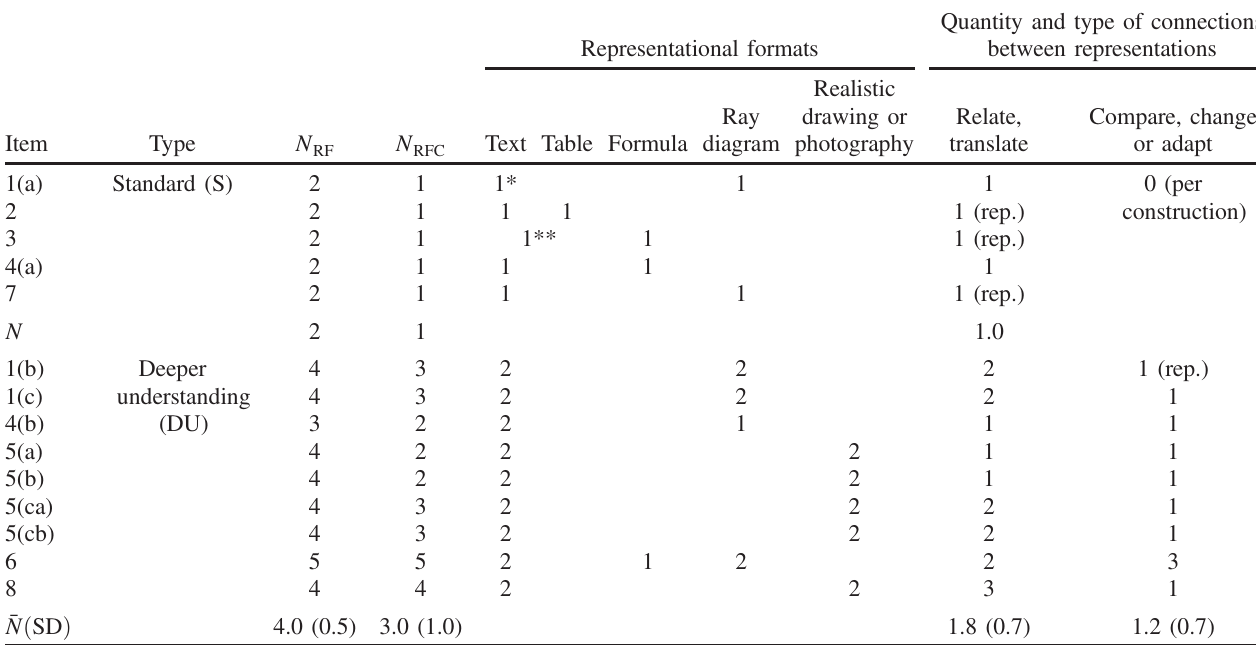
TABLE VII. Overview of the representational formats and their connections used in RCA assessment items (see Ref. [146]; N ¼ number of different representations, N ¼ number of connections between different representations, rep : ¼ repeated, i.e., an RF RFC already constructed connection of representations is used again with another variable and counted only once, (cid:2) ¼ a variable integrated in the text (e.g., focal length ¼ 4 cm) is not counted as separate representation, (cid:2)(cid:2) ¼ table and text combined).